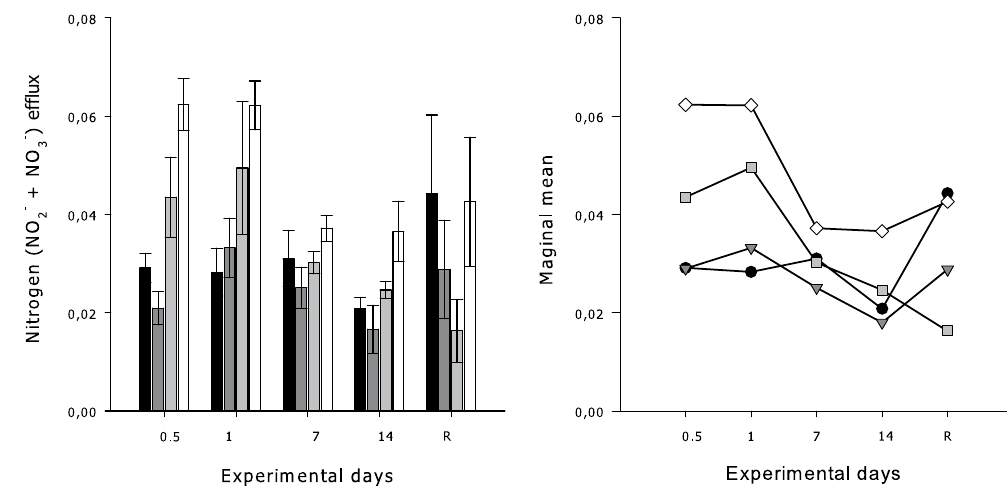
Figure 2. Left panel –Mean net nitrogen efflux rate ( μ mol NO 2 − + NO 3 − g(tissue DW) − 1 h − 1 ) ± S.E. (n = 5) by G. barretti explants exposed to four different temperature levels (7 °C–Black bar, 9 °C–Dark grey bar, 11 °C– Light grey bar & 12 °C–White bar) over a 14 d experimental period. R on the x-axis is respiration at 65 d post exposure (the recovery period), with explants being maintained at ambient temperatures (7 °C) after the 14 d experimental period, irrespective of prior temperature exposure. Right panel –Interaction plot of estimated marginal means of nitrogen (NO 2 − + NO 3 − ) flux rates calculated for each temperature (7 °C–Black circles, 9 °C– Dark grey triangles, 11 °C–Light grey squares & 12 °C–White diamonds) at each exposure day and recovery time period